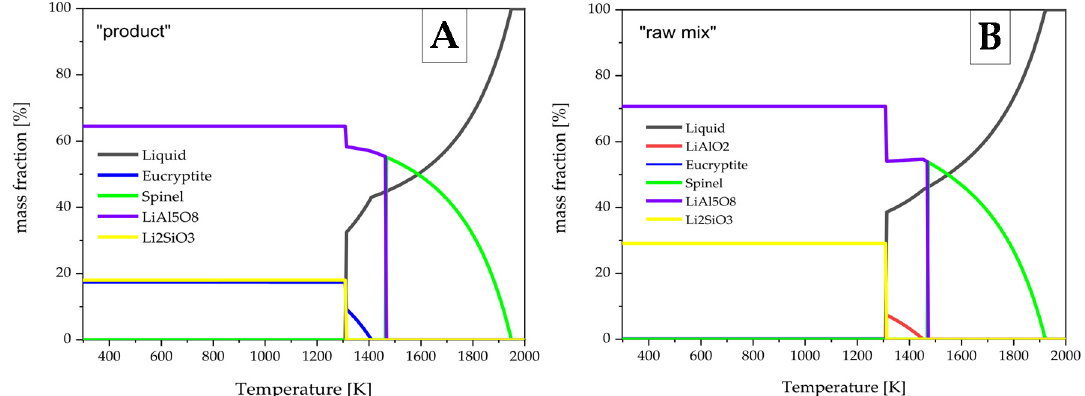
Figure 8. Calculated equilibrium solidification curves of the “product” ( A ) and the “raw mix” ( B ) for Li 2 O-Al 2 O 3 -SiO 2 system. Calculated point interval is 5 K.